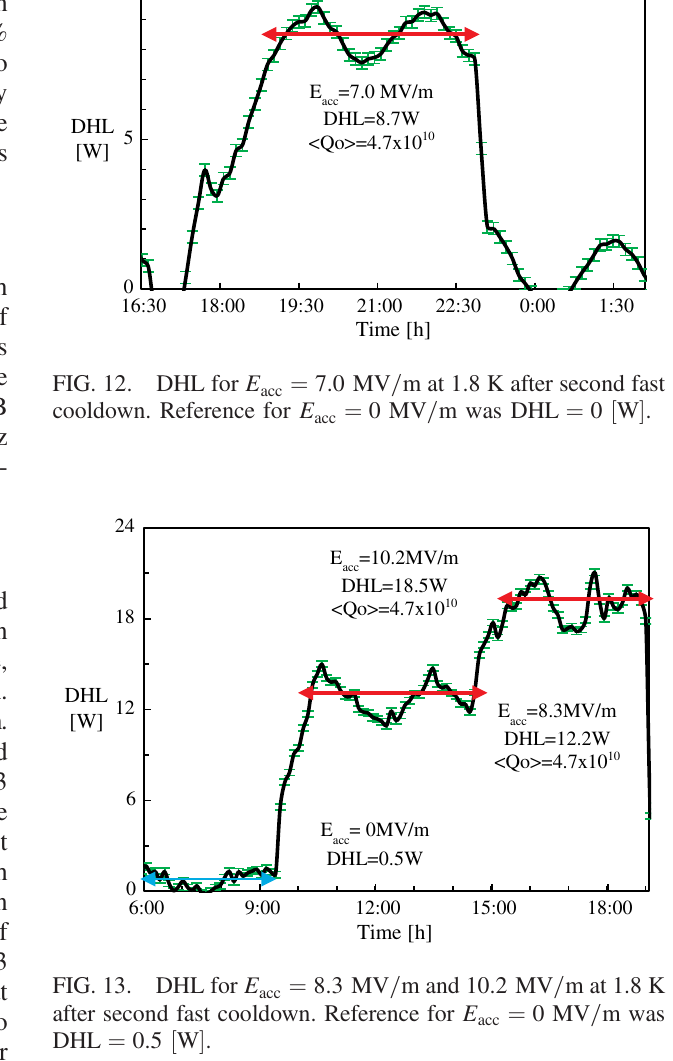
FIG. 13. DHL for E after second fast cooldown. Reference for E DHL ¼ 0 . 5 ½ W (cid:3)